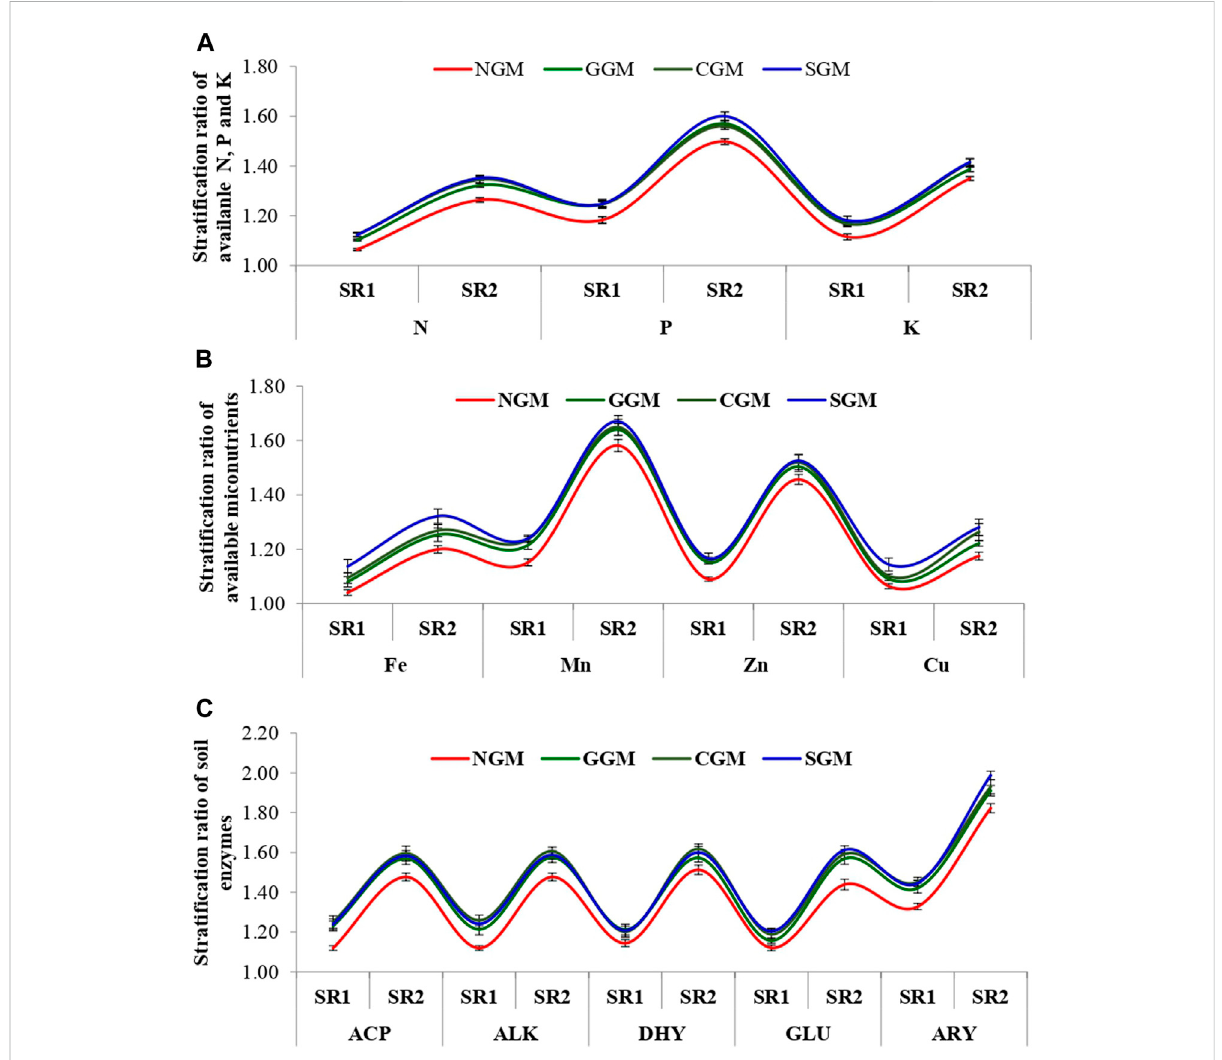
FIGURE 2 Strati fi cation rations of (A) available N, P, and K (B) . Micronutrients Fe, Mn, Zn, and Cu (C) . Soil enzymes as in fl uenced by green manuring after fi ve years of experimentation. NGM: No green manuring, GGM: greengram green manuring, CGM: cowpea green manuring, SGM: sesbania green manuring, R-: residue strati fi cation ratio (ratio of 0.15 – 0.30 and 0.30 – 0.45 m soil depth) ACP: Acid phosphates (ug TPF g -1 of soil h -1 ), ALK: Alkaline phosphates(ugg -1 ofsoilh -1 ),DHY:Dehydrogenase(ugTPFg -1 ofsoilh -1 ),GLU:betaglucosidase(ugg -1 ofsoilh -1 ),ARY:arylsulfataseactivity(ug pNp g -1 of soil h -1 ) vertical bar (both way) represents the standard error of mean (p <